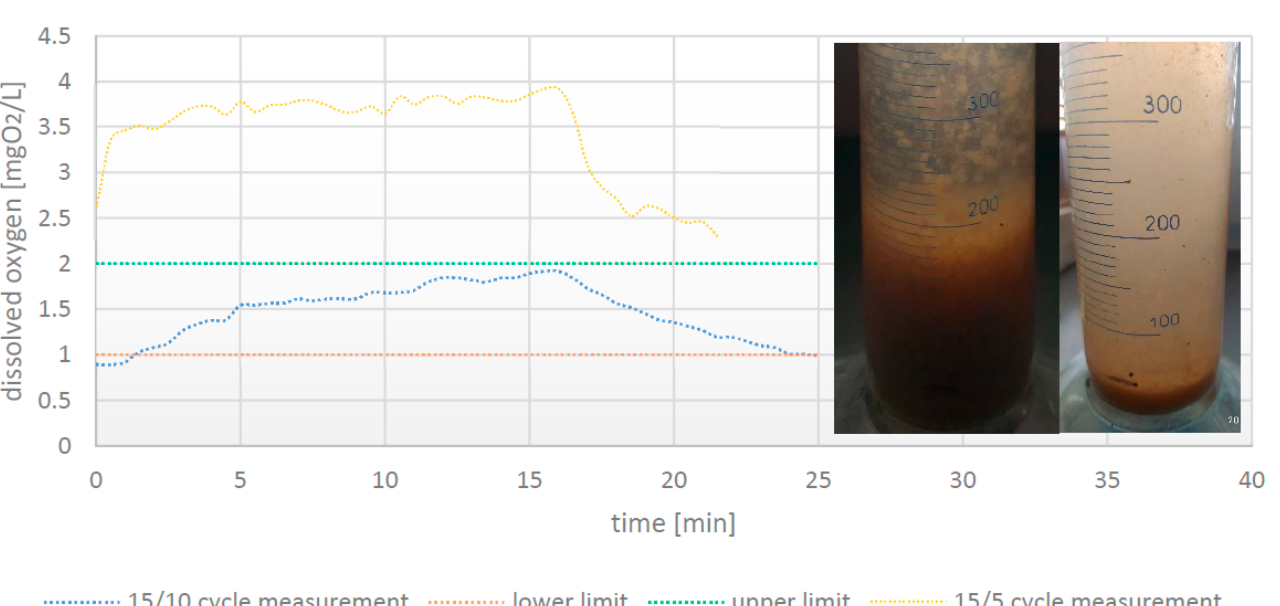
Table 5. Effluent quality characteristic, reliability factor (RF), and technological purity index (TPI) calculated for tested on-site wastewater treatment plant . Parameter